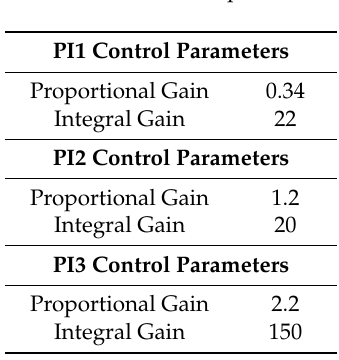
Table 2. The PI control